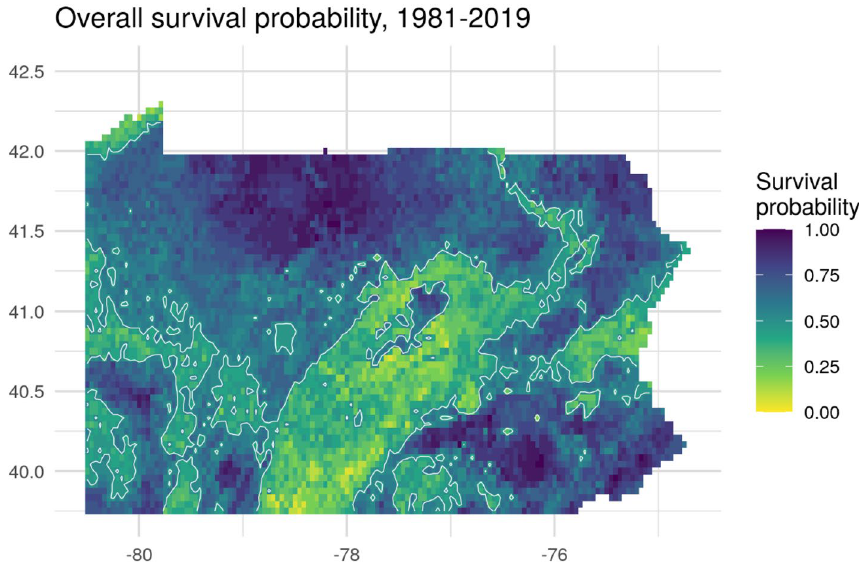
Figure 6. Mean probability of colony survival for 1981–2019 from the weather-only colony model. Contour lines show the 0.5 probability level. The map has been generated by the authors in R 3.6.2 50 , using the sf 72 , the raster 56 , the ggplot2 73 and the cowplot 74